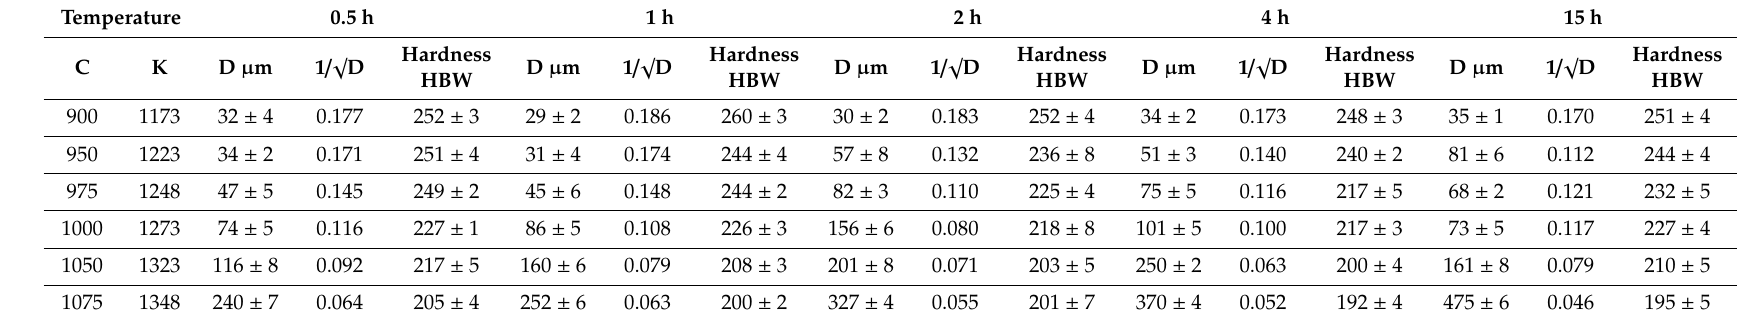
Table A1. Hardness and grain size data utilized for the analysis of the current